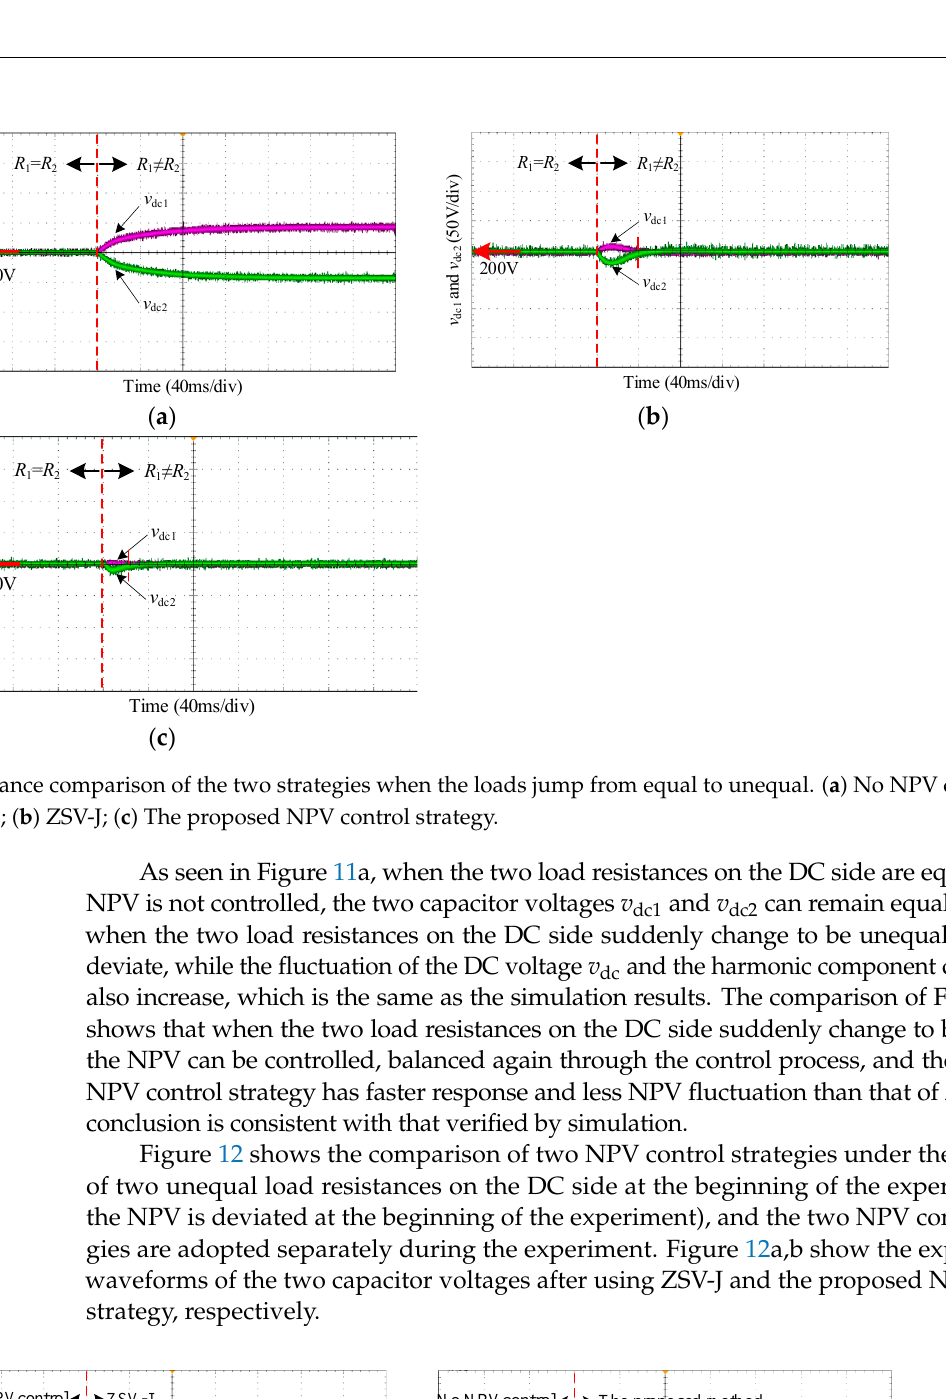
Figure 9. Fourier analysis of i when the proposed NPV control strategy is adopted. ( a ) Harmonic a analysis; ( b ) low-frequency harmonics analysis.